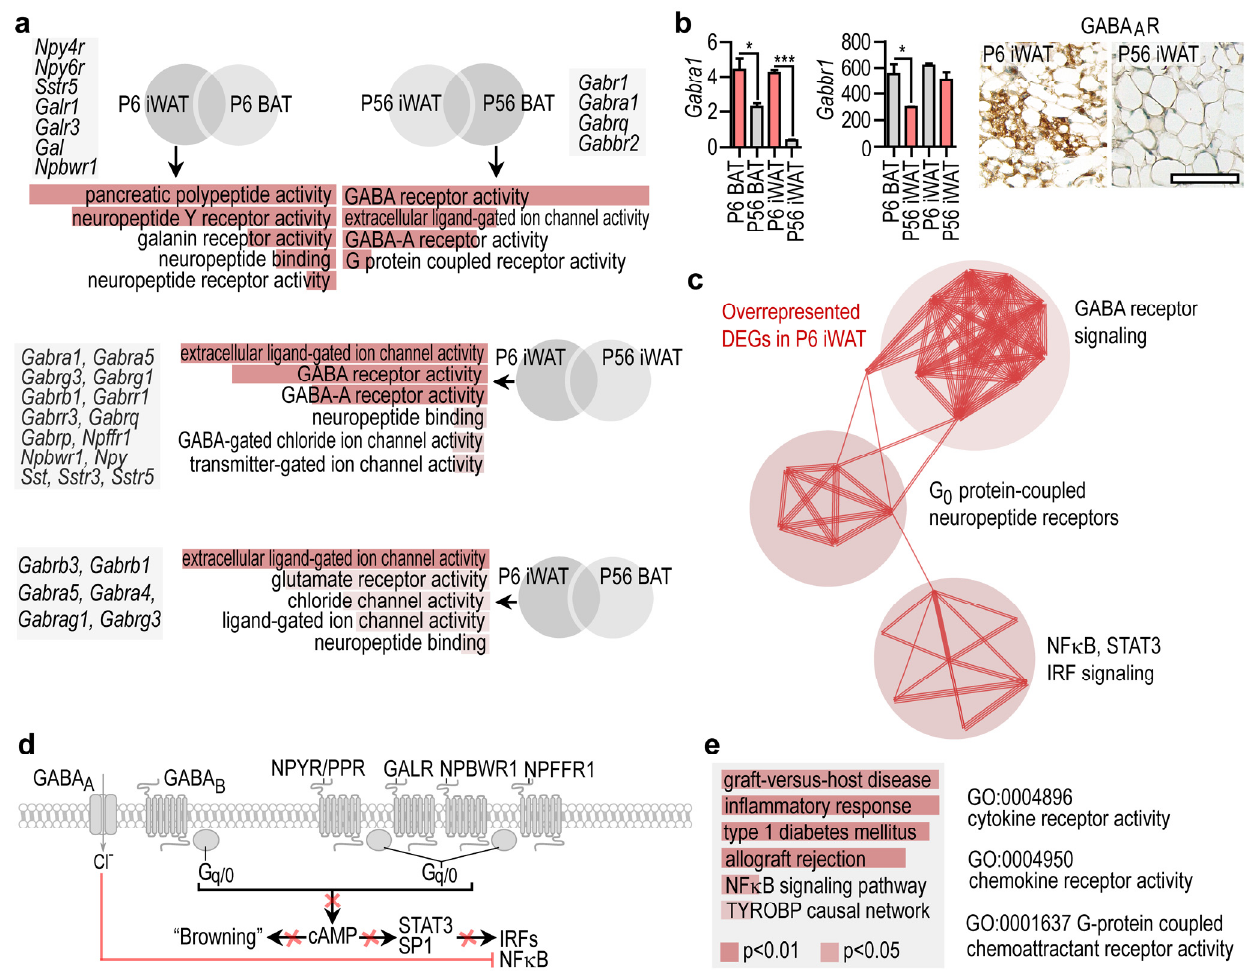
Figure 3. Gene expression pattern shared by P56 BAT and P6 iWAT. ( a ) GO analysis and representative gene transcripts specific to P6 iWAT and P56 BAT. ( b ) Left: Expression level of Gabra1 , encoding GABA-A receptor, and Gabbr1 , encoding GABA-B receptor in P6 iWAT, P6 BAT, P56 iWAT and P56 BAT. * p < 0.05, *** p < 0.001, Student’s two-tailed unpaired t-test. Right: Immunostaining of GABA-A in iWAT at P6 and P56, scale 50 μ m. ( c ) Interactome map of DEGs overrepresented in P6 iWAT. PPI enrichment p -value < 1.0 × 10 − 16 . ( d ) Scheme showing cell compartment association of DEGs overrepresented in P6 iWAT. cAMP is a known signal for transformation of WAT into beige adipocyte-rich depots, in the so-called adipose tissue “browning” process [35]. Red cross denotes inhibition of the respective pathways. ( e ) GO analysis of cellular functions and biological processes of immune-related transcripts in P56 BAT. Combined p -values are indicated with color codes. TYROBP: TYRO protein tyrosine kinase-binding protein.